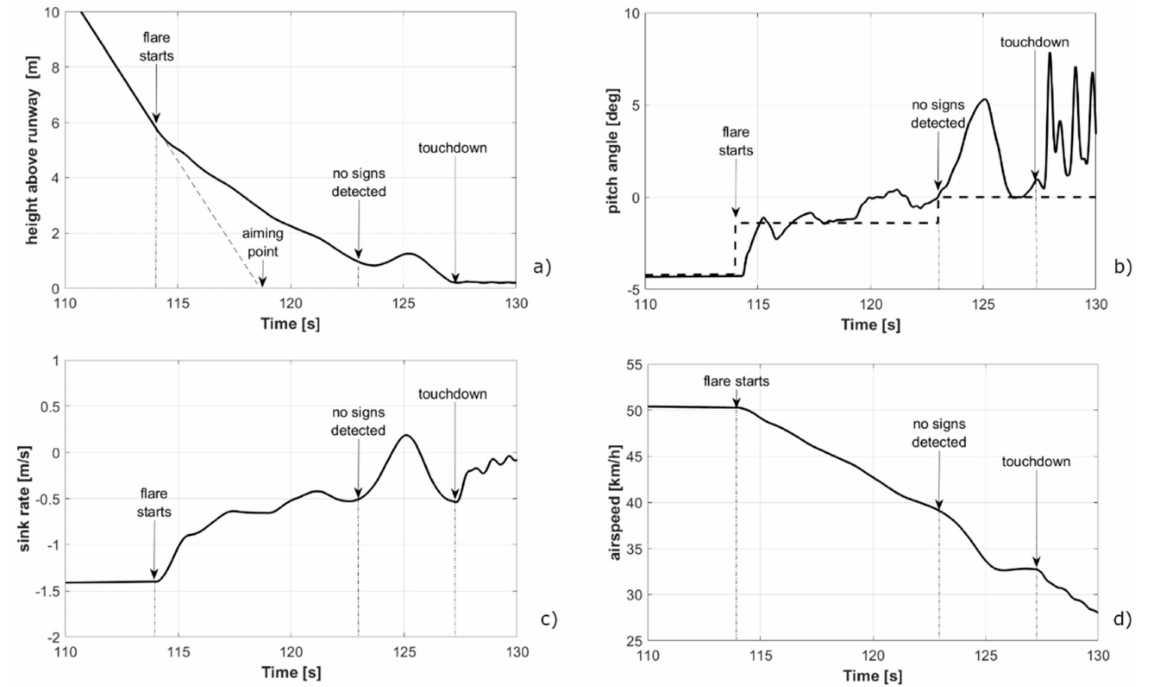
Figure 22. Selected flight parameters in the flare phase; ( a ) height above the runway; ( b ) pitch an-gle; ( c ) sink rate (vertical speed); ( d )